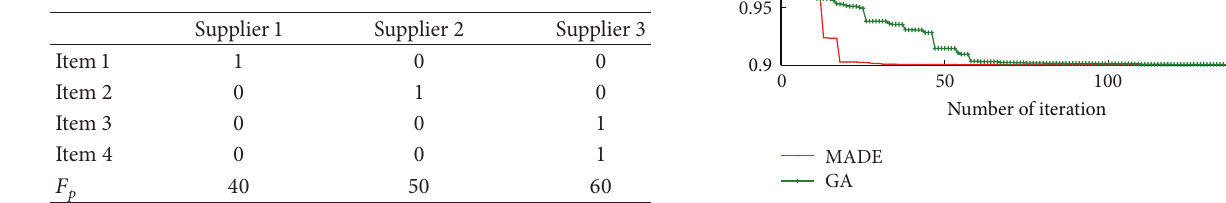
Table 2: The items supplied by suppliers.